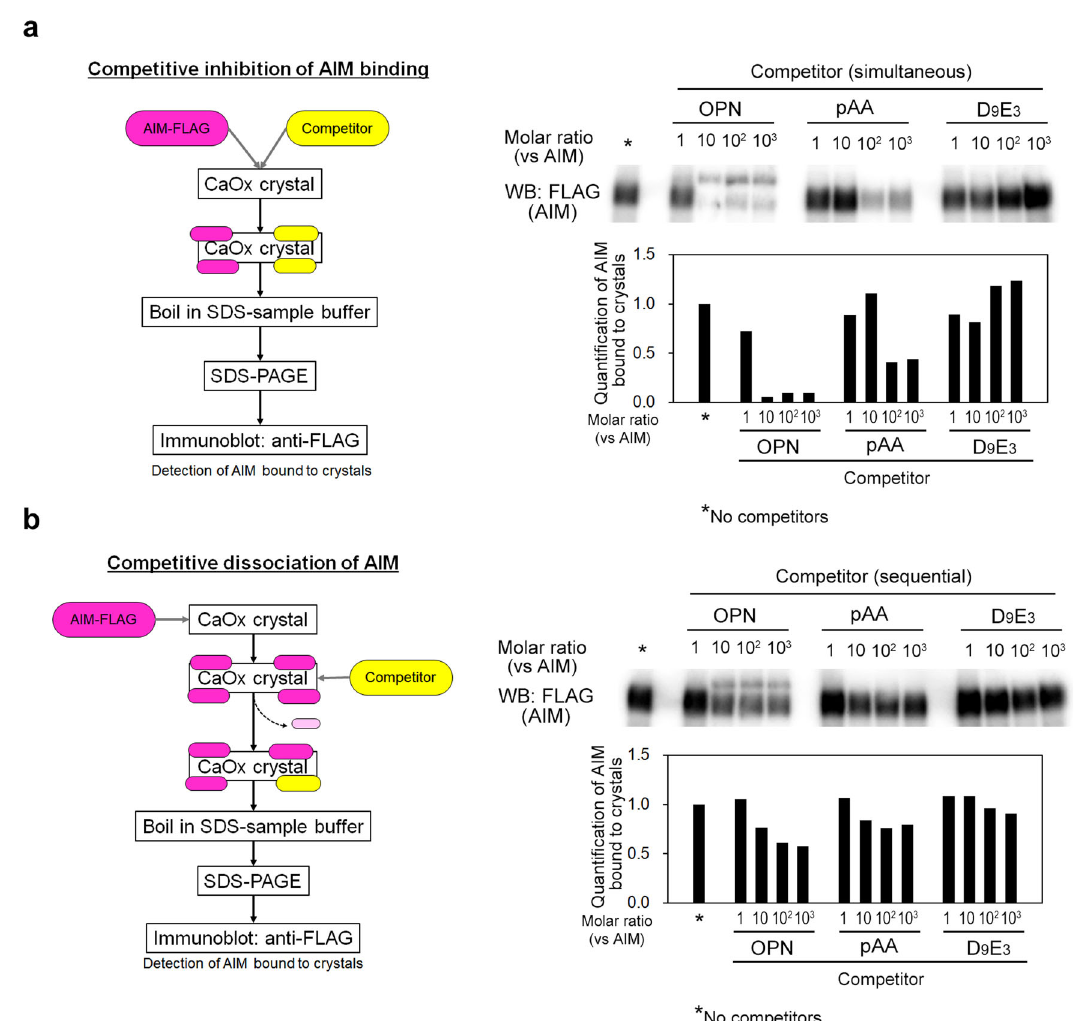
Fig. 4 High binding af fi nity of rAIM to crystals. a Crystals were incubated with FLAG-tagged rAIM (0.5 µ g/mL) and either rOPN, pAA 5.1 , D 9 E 3 peptide (presented as competitor), or PBS (presented as *) at different molar ratios at 37 °C for 1 h. Thereafter, the crystals were washed with PBS, boiled in an SDS-PAGE loading buffer, and the rAIM bound to the crystals was assessed by immunoblotting. The values of AIM signals are relative to that of the crystals incubated with only rAIM (left lane indicated as *). b Crystals were pre-incubated with rAIM (0.5 µ g/mL) at 37 °C for 1 h, and thereafter washed with PBS. The crystals were then incubated with the indicated substances at different molar ratios relative to that of rAIM. After additional incubation for 1 h, the remaining rAIM on the crystals was assessed as in a . In both experiments, representative results are presented. Similar results were obtained in three independent